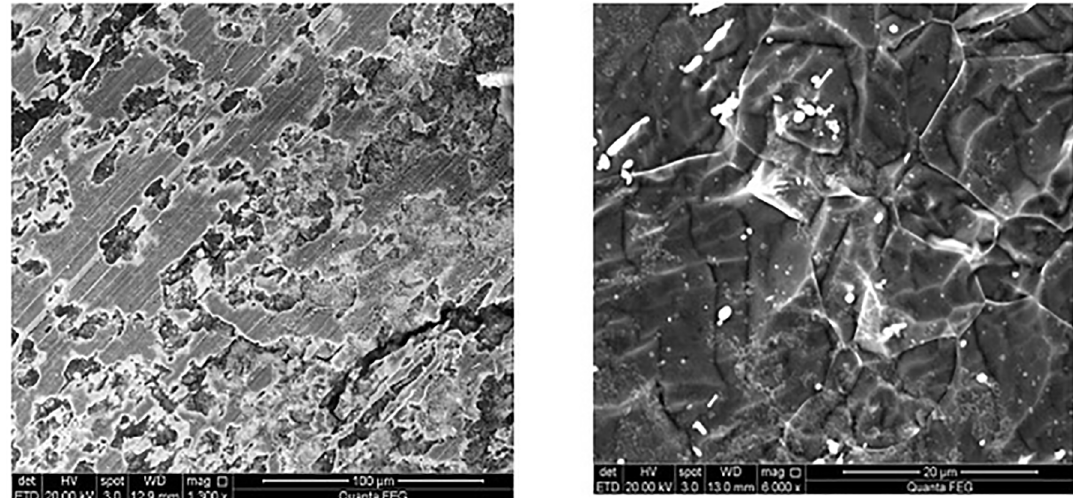
Figure 2 . (a) EDX spectrum and quantitative analysis of the coated AISI 304 steel with hybrid TiO 0.5:0.5 containing 2 wt. % nanoparticles before the corrosion test, (b) EDX spectrum and quantitative analysis of the coated AISI 304 -ZrO coating with a mix ratio of 0.3:0.7 containing 2 wt. % nanoparticles before the corrosion test. steel with hybrid TiO 2 2